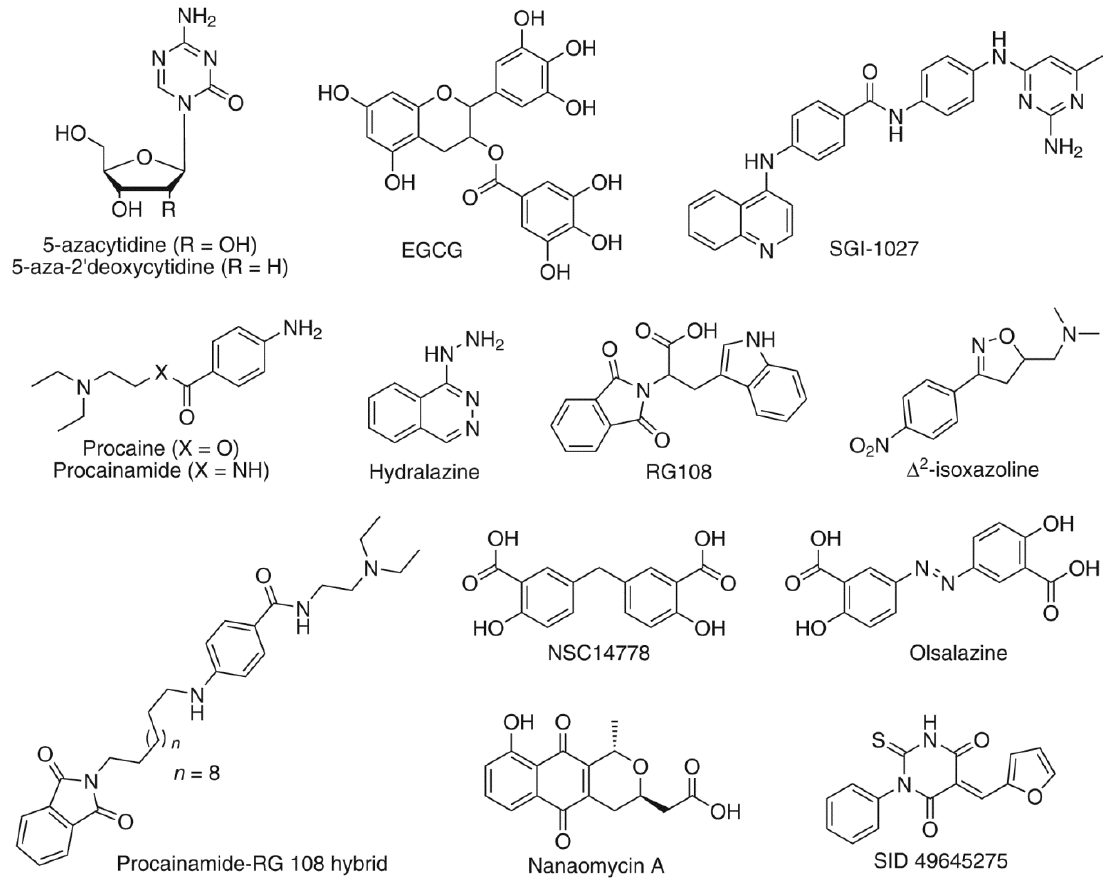
Figure 1. Selected compounds associated with DNA methyltransferases (DNMT) inhibition and hypomethylating agents.